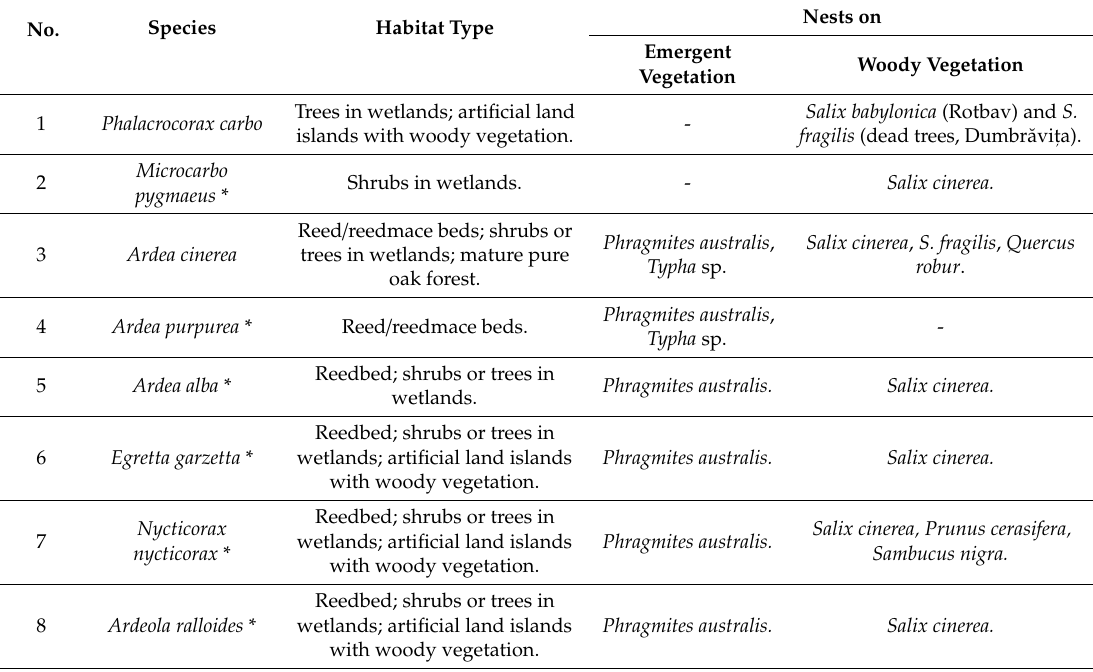
Table 1. Breeding habitats and nest-building